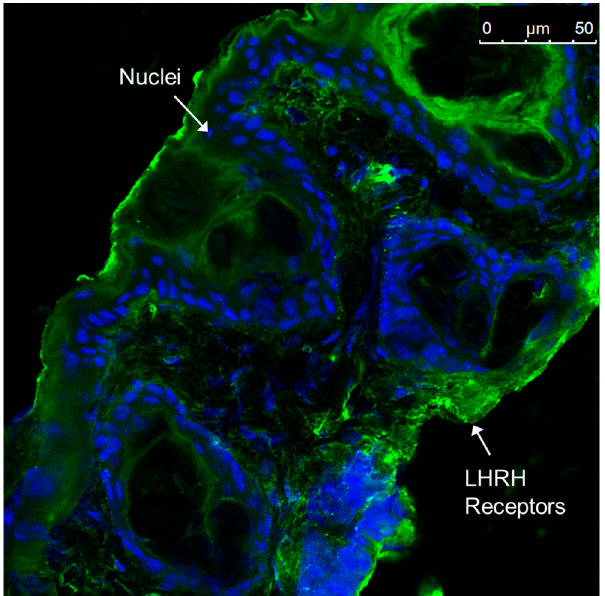
Figure 10. Immunohistochemistry staining of excised breast tumor tissue 4-weeks post tumor induction, showing expressed LHRH receptors (green). Cell nuclei were labeled by DAPI (blue).